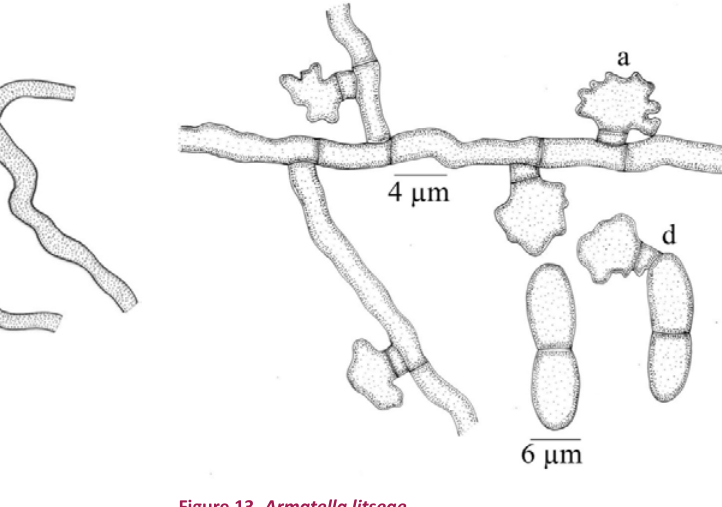
Figure 12. Armatella katumotoi a - Appressoriate mycelium; d - Ascospores